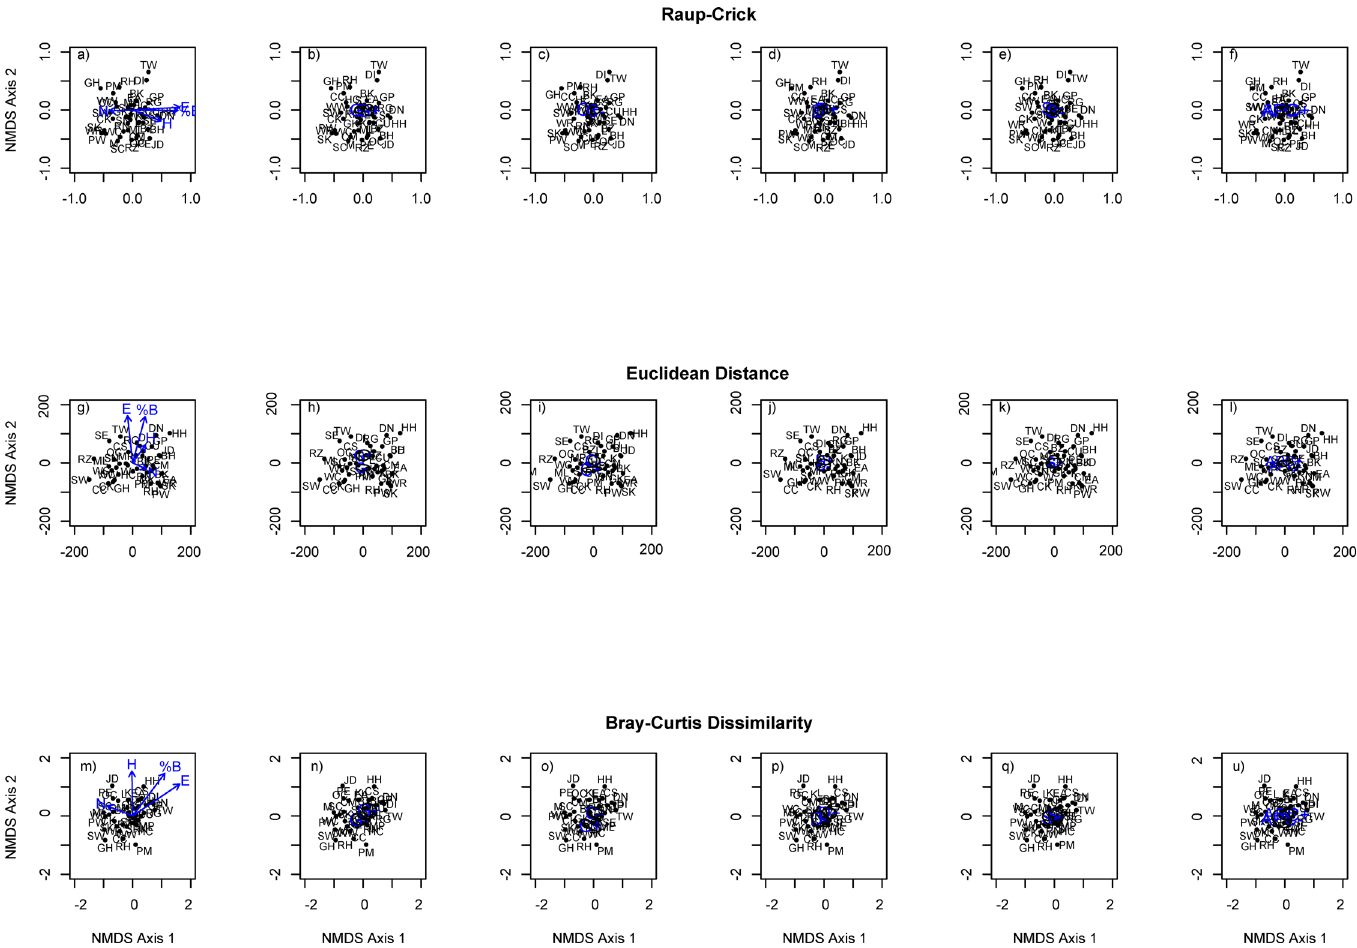
Fig 2. Ordination plots of Raup-Crick (a-f), Euclindean Distance g-l), and Bray Curtis Dissimilarity (m-u) with 95% Standard Error centroids showing species associated with dominant management and management activities (e.g. G+ denotes estates managed for grouse and G- indicates the rest of the estates). Species are coded following British Trust for Ornithology survey codes; Mallard — MA; Tufted Duck — TU; Red Grouse — RG; Ptarmigan — PM; Black Grouse — BK; Pheasant — PH; Red-throated Diver — RH; Cormorant — CA; Grey Heron — H.; Hen Harrier — HH; Buzzard — BZ; Golden Eagle — EA; Kestrel — K.;